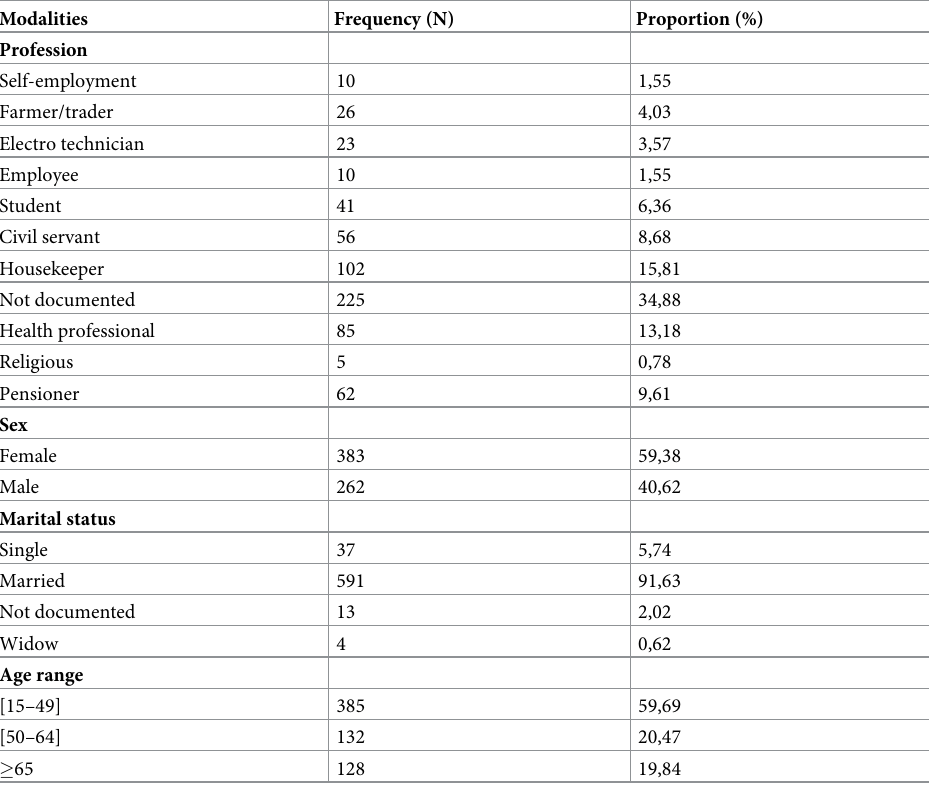
Table 1. Socio-demographic characteristics of the COVID-19 confirmed cases admitted to BRH.